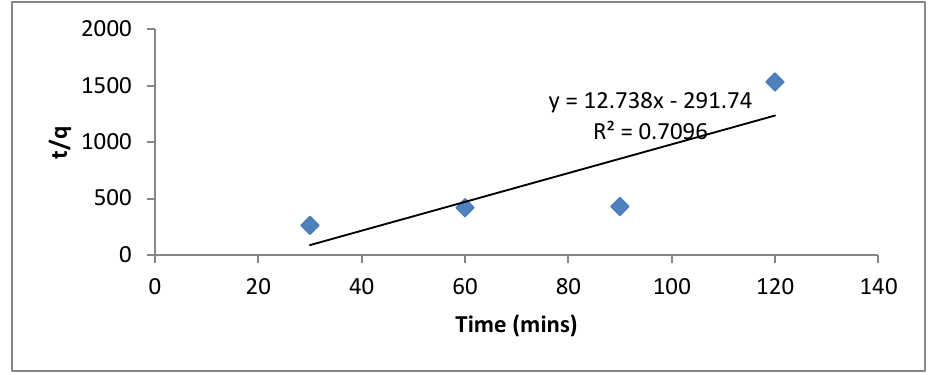
Figure 11: Pseudo second order for chromium removal by banana peel